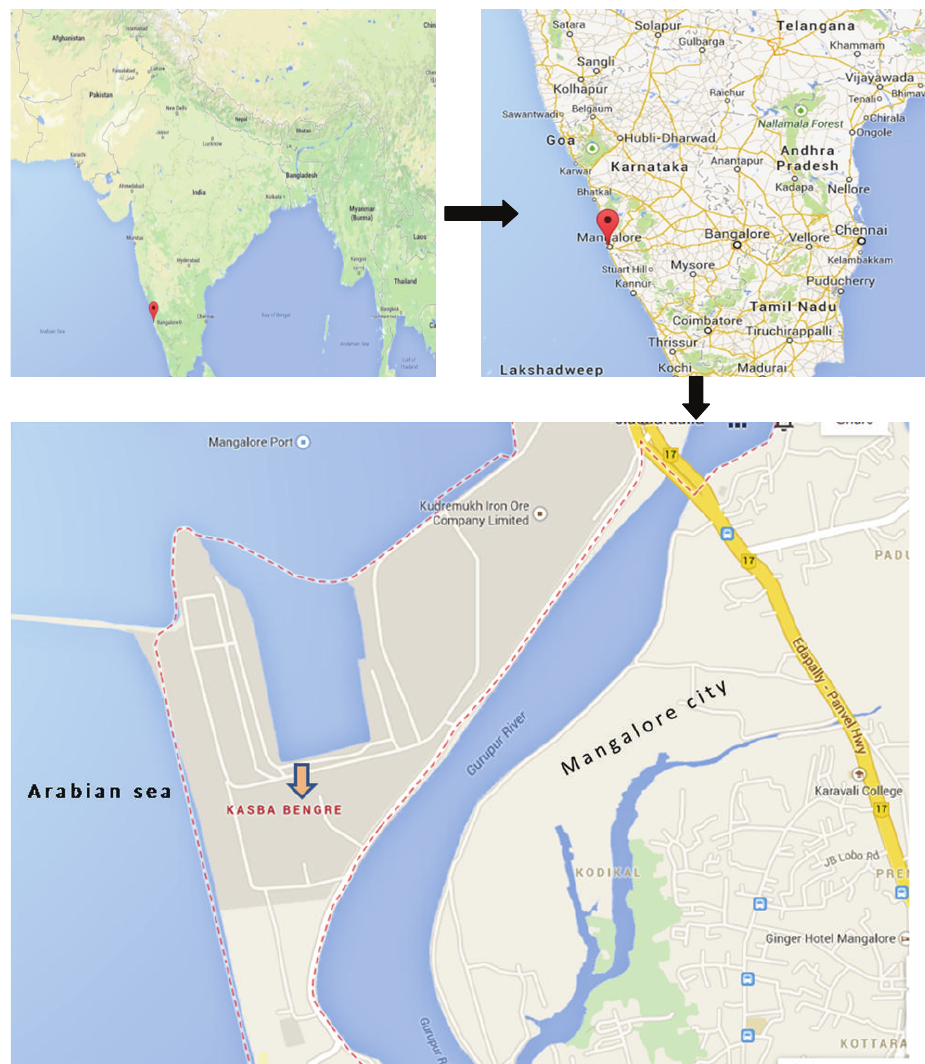
Figure 1: Bird’s view of the study area Bengre in Mangalore City, India